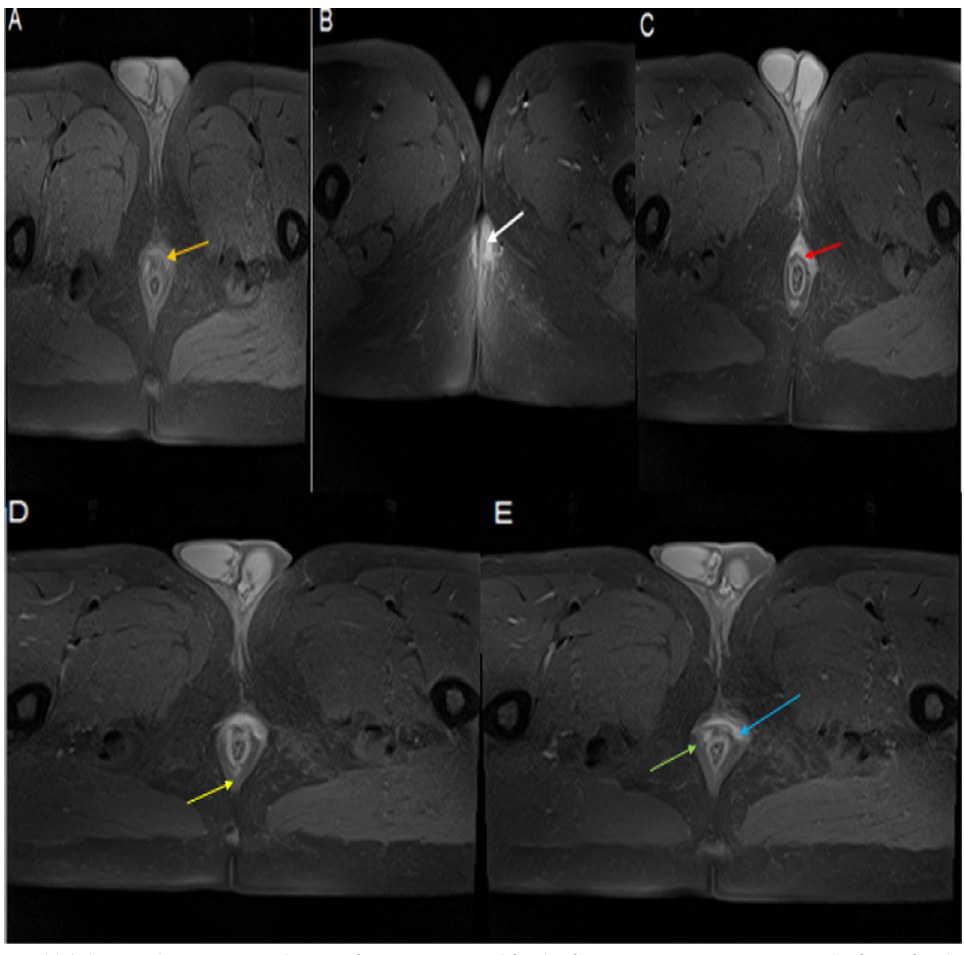
Fig. 8 A 40-year-old diabetic male patient complaining of recurrent perianal fistula after surgery. MRI examination in the form of multiple pulse sequences after IV contrast injection revealed in pre-contrast axial Fat Sat T1 images: A a faint horseshoe fistulous tract at the intersphincteric space (orange arrow). Post-contrast axial Fat Sat T1 images ( B – E ) showed: B external cutaneous opening of the branched fistulous tract in the left perianal region (white arrow). C An enhanced fistulous tract seen in the intersphincteric space with secondary branches (red arrow). D One branch seen connected with the anal canal at six o’clock (yellow arrow). E The enhanced fistulous tract forming a horseshoe extension (blue arrow) connected with the anal canal at 11 o’clock (green arrow). The final diagnosis was a left, grade II, intersphincteric